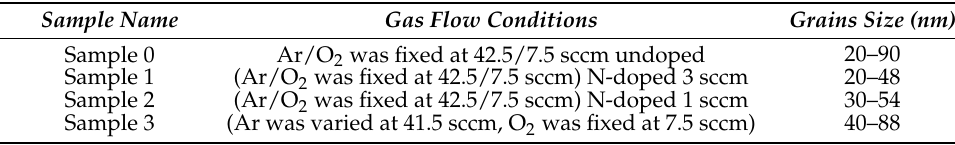
Table 2. Layer structure of Cu 2 O:N thin films